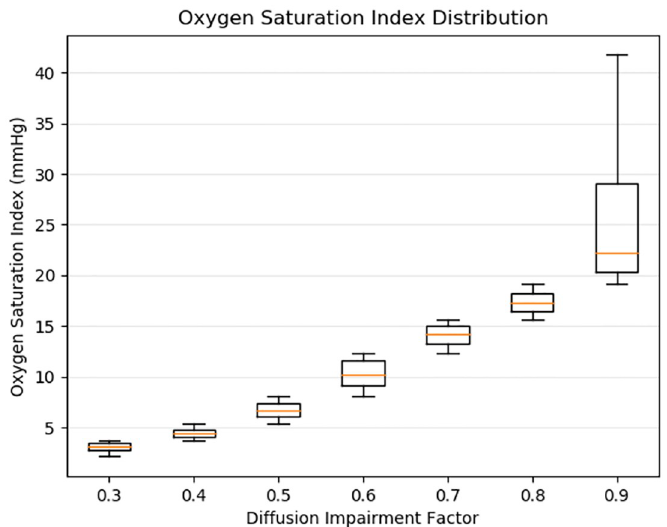
Fig 5. Distribution of all simulated patient’s OSI grouped by the seven DIF settings used from mild to severe. The OSI increases with DIF and is, therefore, useful for non-invasive clinical assessment of hypoxemic respiratory failure. The OSI increases with diffusion impairment because the SpO 2 , which plateaus at 100, is a proportionately larger fraction of PaO 2 as diffusion impairment and shunt make PaO 2 less than expected for a given FiO 2